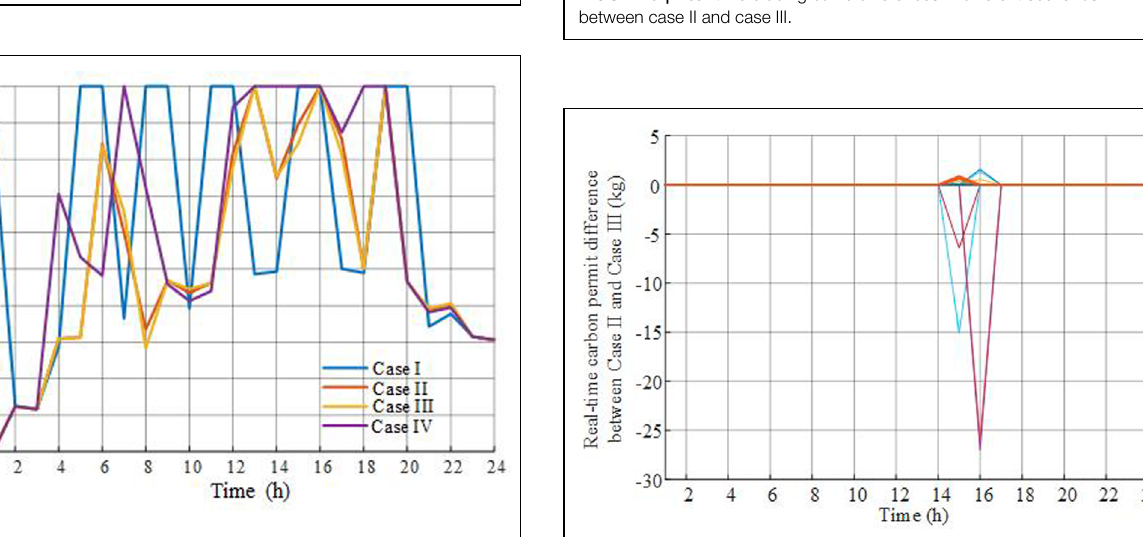
FIGURE 6 | Real-time bidding curve differences in different scenarios between case II and case III.